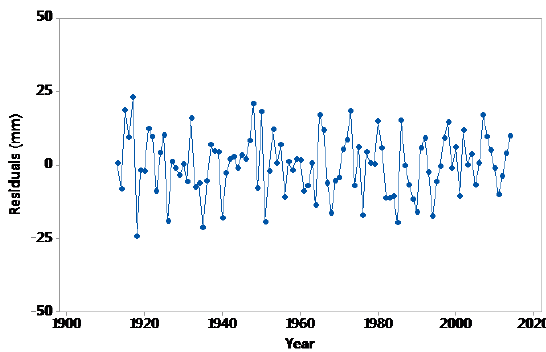
Figure 9: Final model solution residuals in mm.